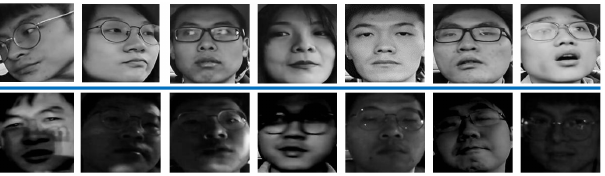
Figure 8. Facial samples from the collected on-road driver facial expression dataset; the top row shows day samples and the bottom row shows night samples. Table 4. Comparison of model performance under day and night